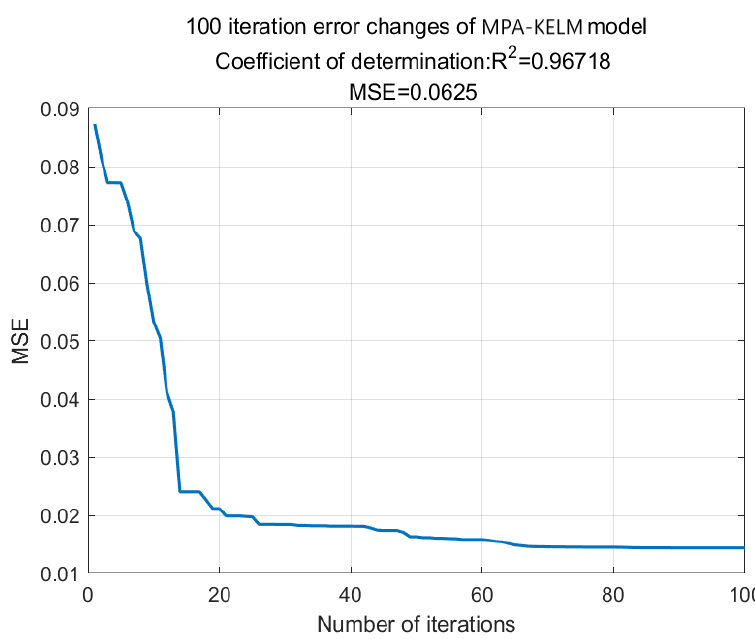
Figure 5. Convergence diagram.